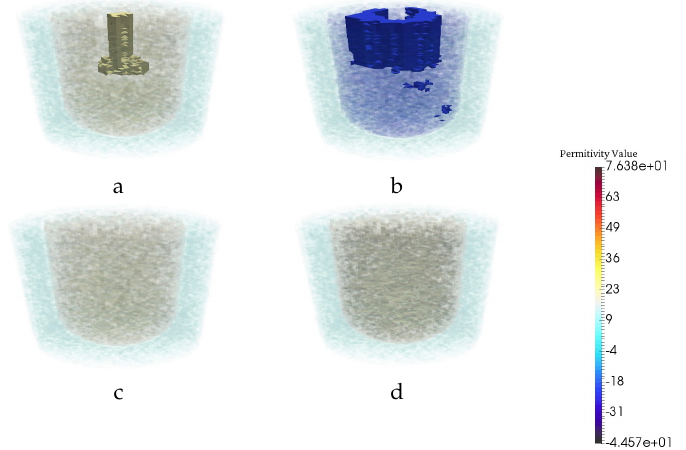
Figure 10. Reconstruction results for a particular example when the training images are CSI results with one or two tumors but the neural net was tested on a phantom with no tumor. The real ( a ) and imaginary ( b ) part of CSI reconstruction. ( c ) CNN reconstruction. ( d ) Ground